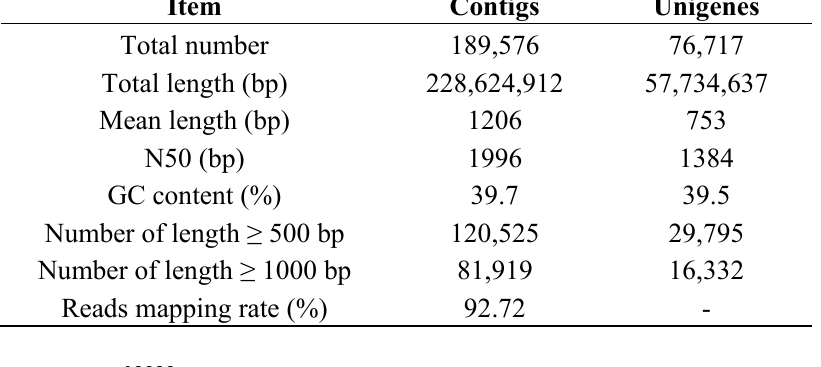
Table 2. Summary of the transcriptome assembly of G. rigescens .